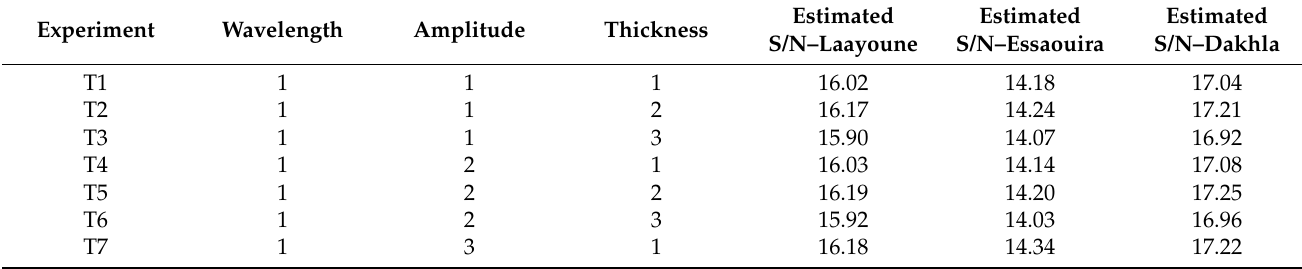
Table A1. Estimated SN ratio for the three cities using the additive